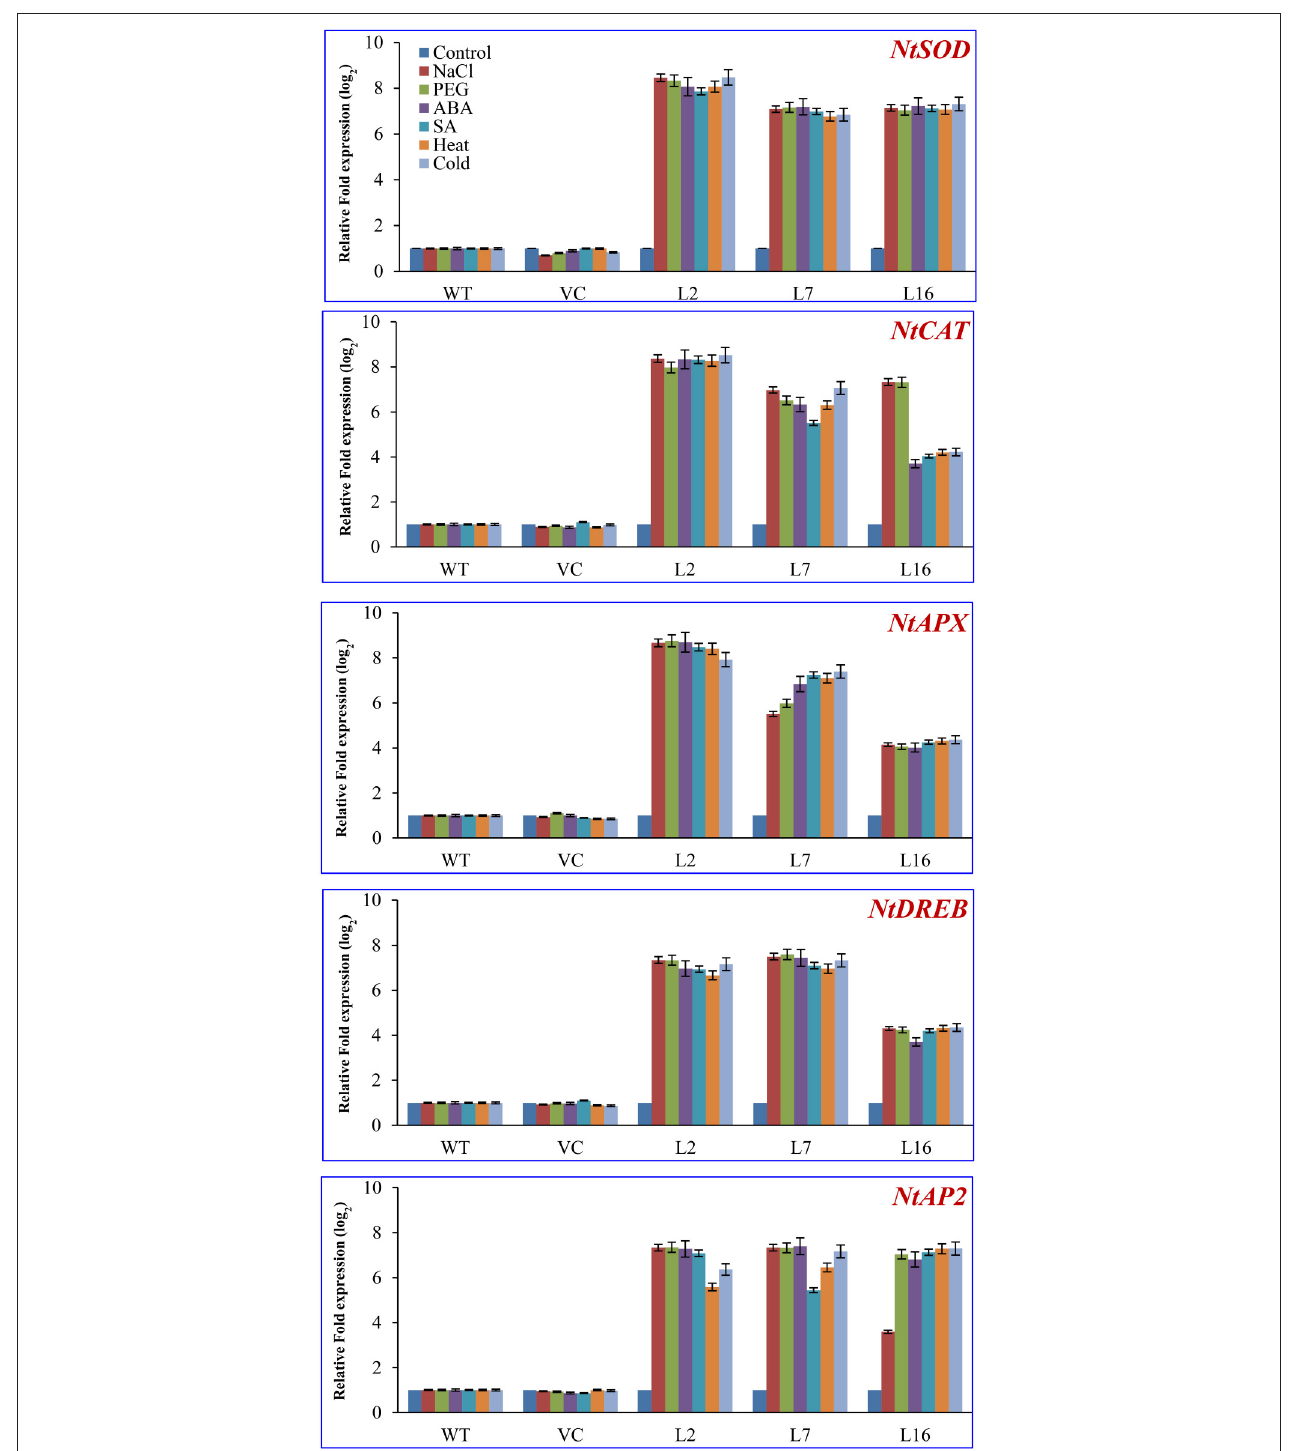
FIGURE 7 | Transcript expression analysis of host stress responsive genes. Comparative transcript expression profile of antioxidant and transcription factor genes of the host plant ( NtSOD , NtAPX , NtCAT , NtDREB , and NtAP2 ) under different stress conditions. The fold expression values obtained in WT (control or stress) were taken as one, relative expression change was calculated for VC and transgenic lines, and presented as relative fold expression (in log 2 ). The housekeeping gene β -tubulin was used as a reference.